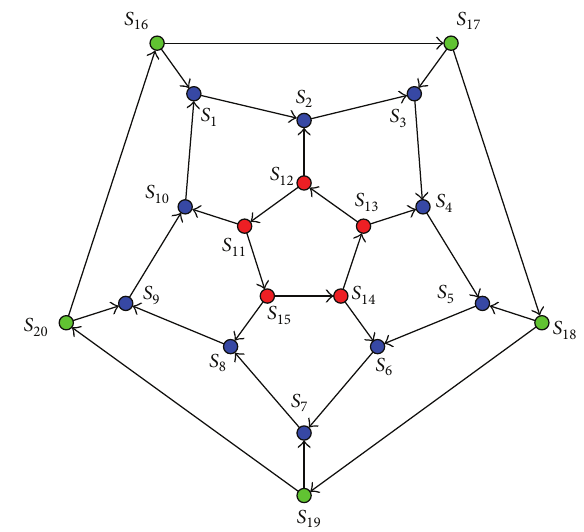
Figure 4: Digraph of 20